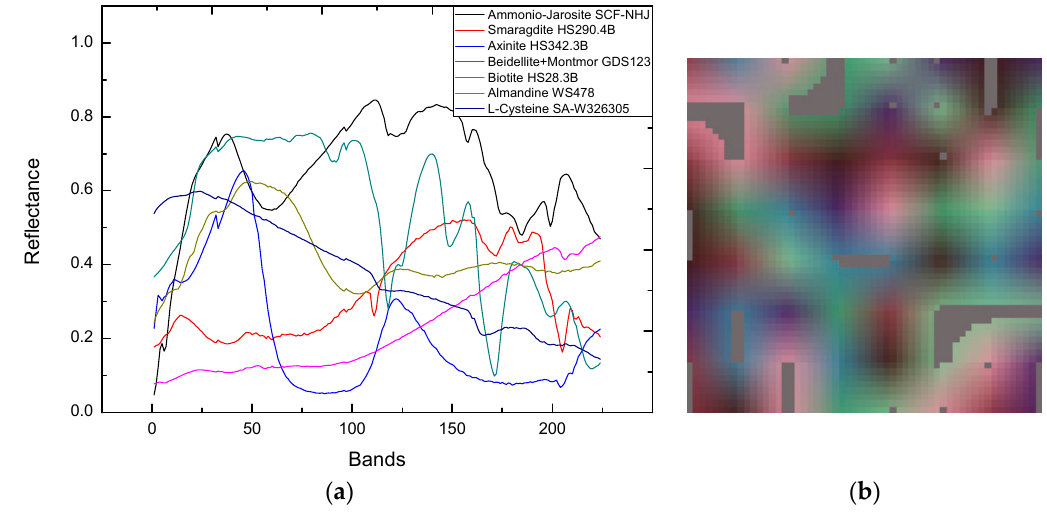
Figure 2. Example of the synthetic data: ( a ) endmember spectra and ( b ) false-color image.